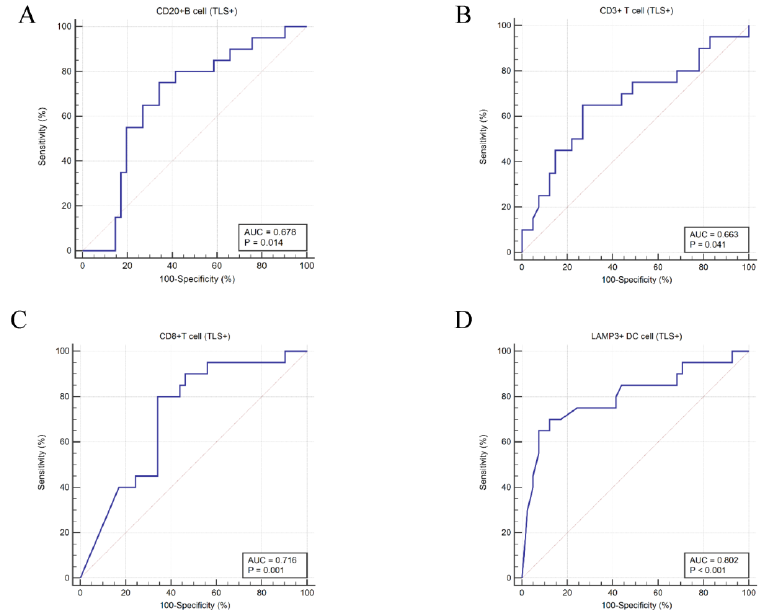
Figure 5. Xijing Hospital data, ROC curves drawn based on the levels of TILs in TLSs. ( A ) CD20+ B Figure 5: ROC curves drawn based on the levels of TILs in TLSs: (A) CD20+ B cells; 294 cells; ( B ) CD3+ T cells; ( C ) CD8+ T cells; ( D ) LAMP3+ DCs. (B) CD3+ T cells; (C) CD8+ T cells; and (D) LAMP3+ DC cells. 295 296 Molecular Mechanisms by which TLSs Regulate the Response to Immunotherapy 297 TLS-related Molecule Expression 298